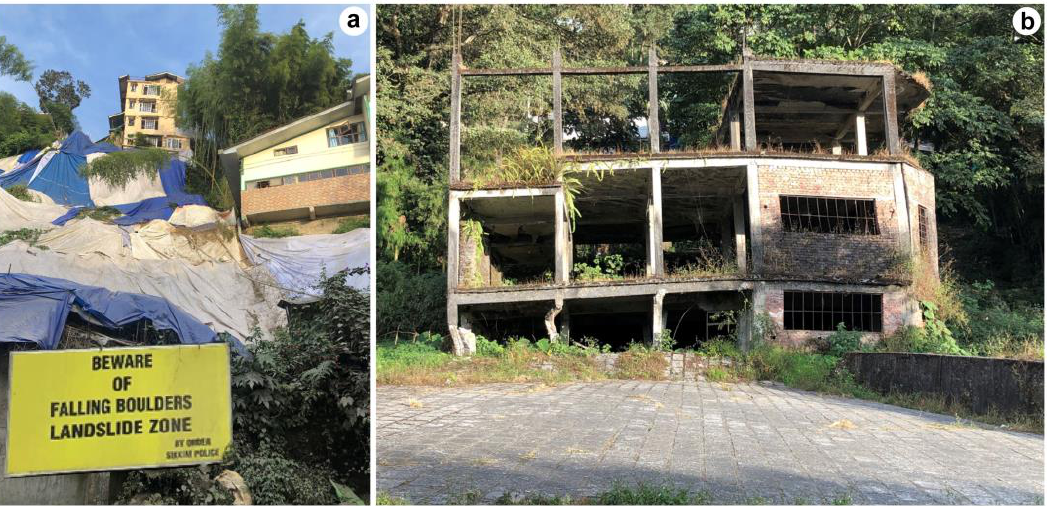
Figure 7. ( a ) Collapse of a residential building in Sichey where the area is covered with plastic sheets to avoid seepage of water from precipitation. ( b ) Abandoned construction of a Tibetan school in lower Sichey due to differential displacements on the ground caused by creeping of the area.